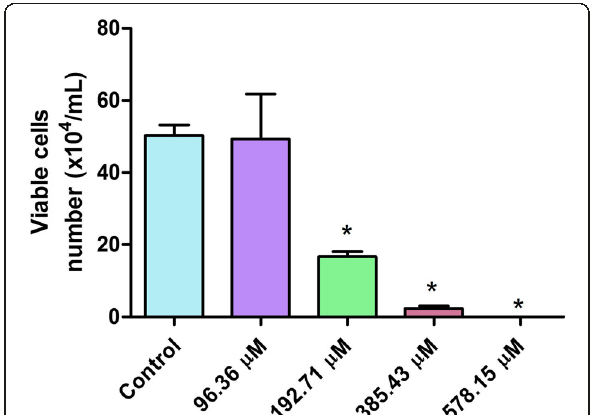
Figure 2 Number of HTC viable cell by trypan blue exclusion test 24 hours after exposure to different concentrations of Microcystis aeruginosa strain 9501 (578.15 to 93.36 μ M) which produces [D-Leu 1 ] MC-LR. Data are expressed as mean + standard error. *Indicates significant difference from the control (p <